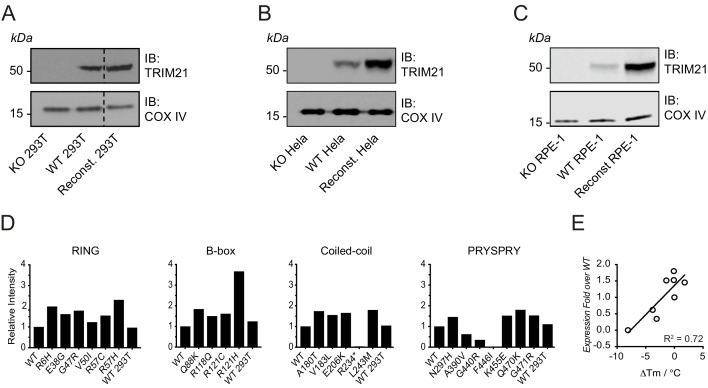
TRIM21 expression levels in reconstituted cell lines.(A–C) Immunoblot of TRIM21 and COX IV (loading control) in TRIM21 KO (KO), WT or native promoter lentivector reconstituted (Reconst.) cell lines (A) 293T, (B) Hela, (C) hTERT-RPE-1. (D) Quantification of TRIM21 variant expression in reconstituted 293Ts (from Figure 5D) normalized to wild-type expression level. (E) Correlation between intrinsic stability (Tm) and cellular expression levels of PRYSPRY variants using linear regression analysis in GraphPad Prism7 (R2 = 0.72). Data provided in Figure 5—source data 1.